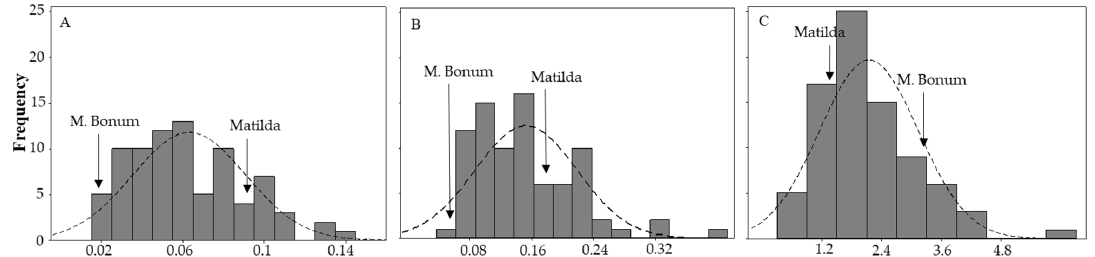
Figure 1. Phenotype distributions of ( A ) relative area under the disease progress curve (rAUDPC); ( B ) relative area under the defoliation curve (rAUC) and ( C ) volume of the infected area on tubers (cm 3 ) for early blight disease among the offspring. Table 1. Analysis of variance for foliar resistance and defoliation.